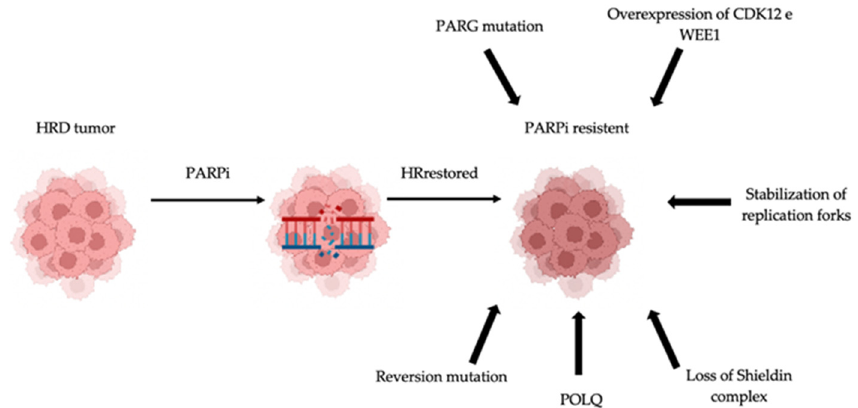
Figure 2. Mechanism of resistance to polyADP-ribose polymerase (PARP) inhibitors. Several resistance mechanisms have been identified: reversion mutation, DNA polymerase θ (POLQ), loss of shieldin complex, stabilization of replication fork, increased drug efflux, overexpression of cyclin- dependent kinase 12 (CDK12) and WEE1.